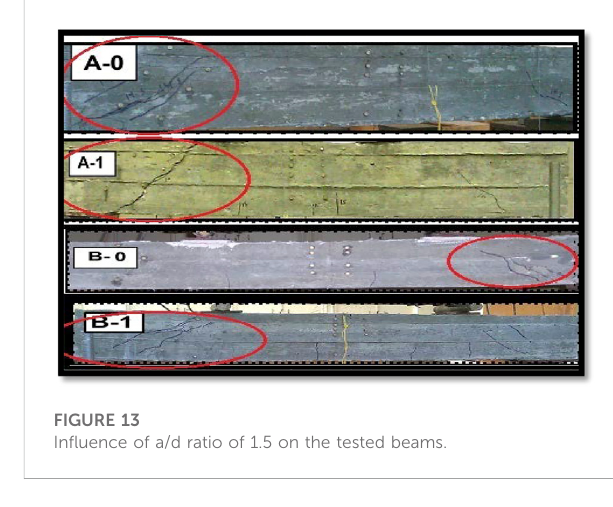
FIGURE 13 In fl uence of a/d ratio of 1.5 on the tested beams.